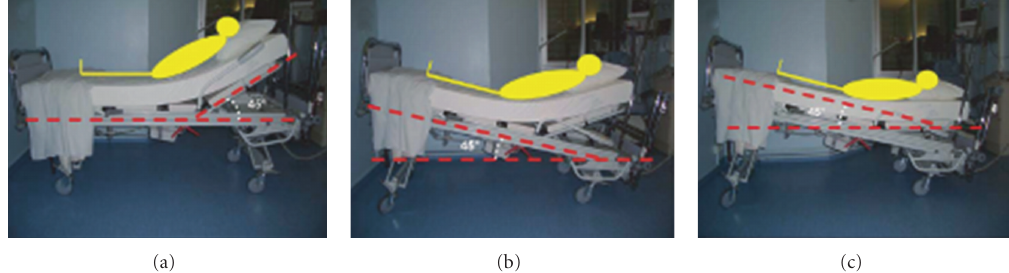
Figure 4: The realization of a passive leg raising maneuver in three steps: (a) at baseline the patient is laying in a semirecumbent position, the trunk of the patient at 45 ◦ up to the horizontal; (b) the entire bed is pivoted to obtain a head down tilt at 45 ◦ . (c) The head of the bed is adjusted to obtain a strictly